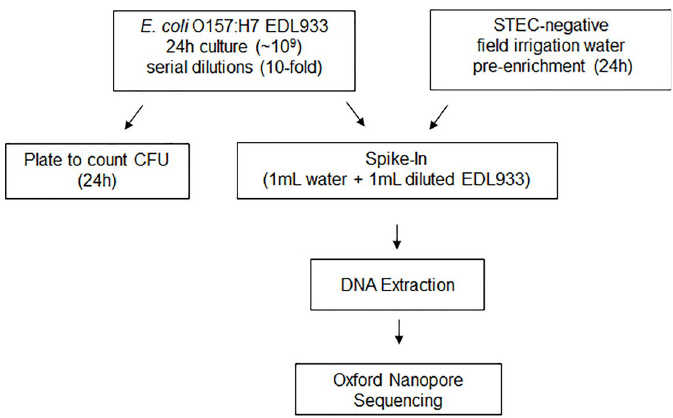
Fig 2. Flow diagram of artificial contamination of enriched, STEC-negative irrigation water through analysis by nanopore sequencing.